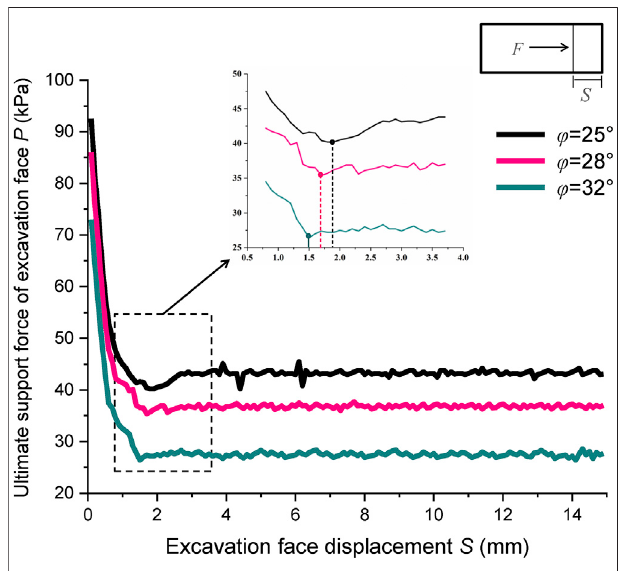
FIGURE 4 | Relationships between support pressure and tunneling face displacement under the different internal friction